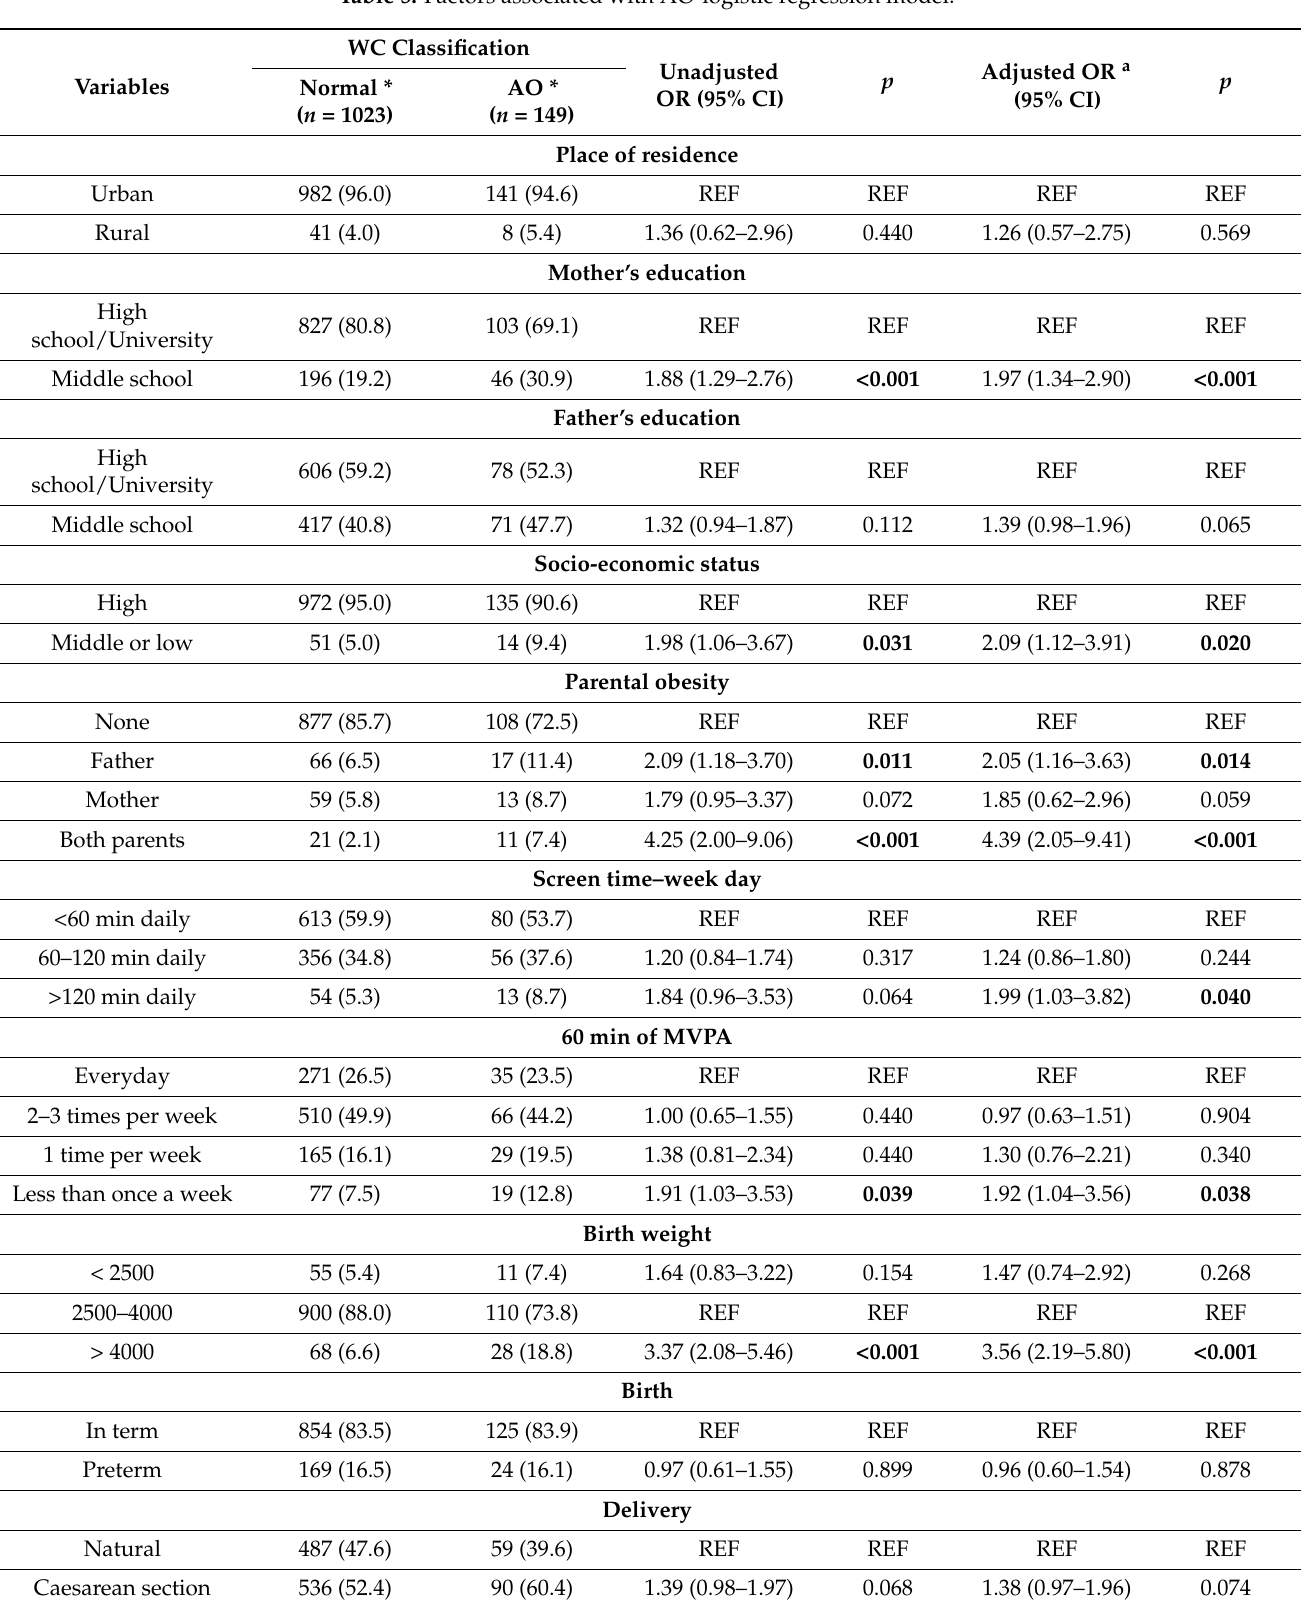
Table 5. Factors associated with AO-logistic regression